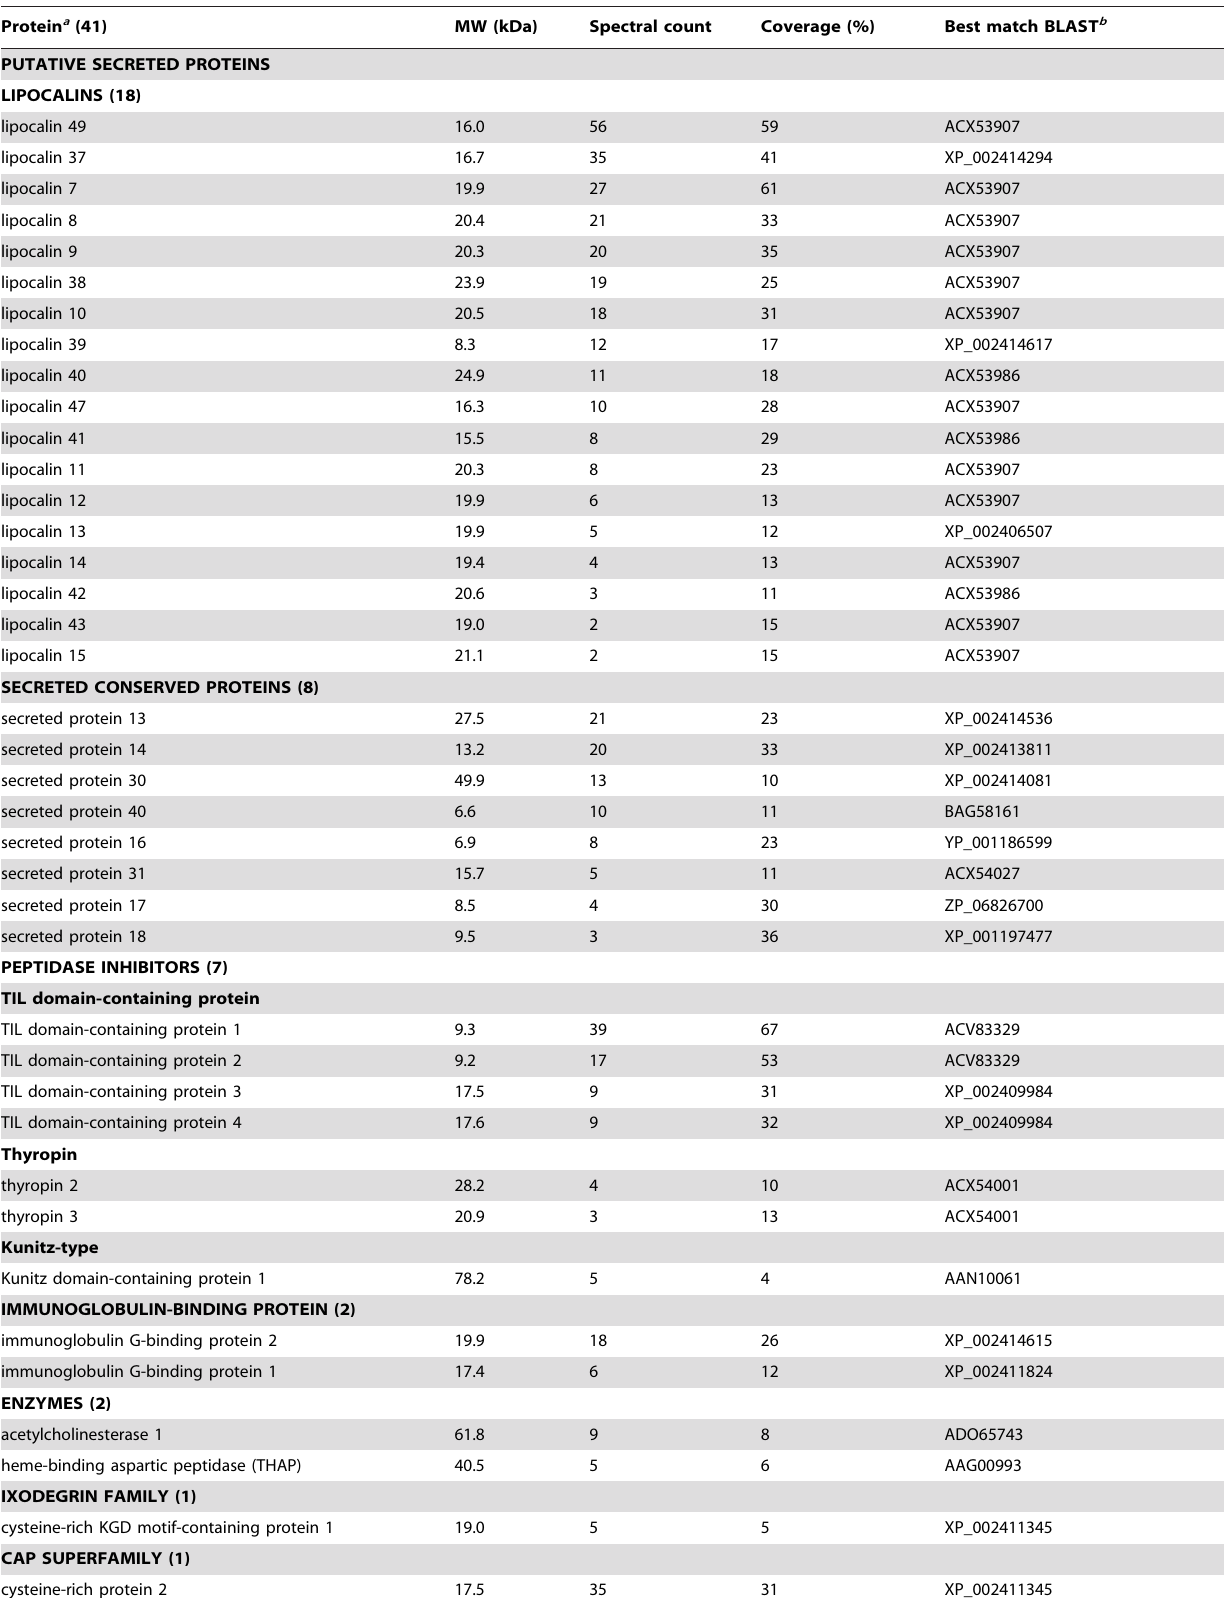
Protein a (41) MW